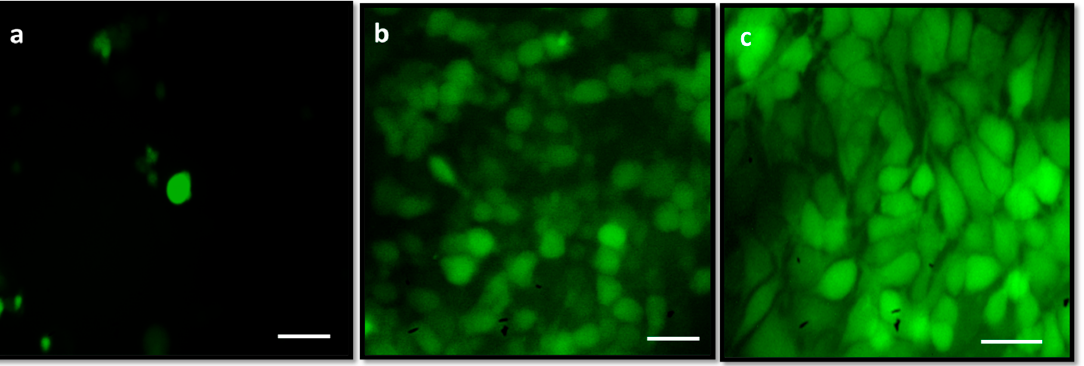
Figure 8. A fl uorescence microscope image of endogenous ROS accumulation promoted by albumin visnagin NPs stained with DCFH-DA. Control ( a ), cells exposed to albumin visnagin NPs and IC25 ( b ) and IC50 ( c ). Image representing a triplicate experiment at 200X magni fi cation (scale bar = 100 mm).